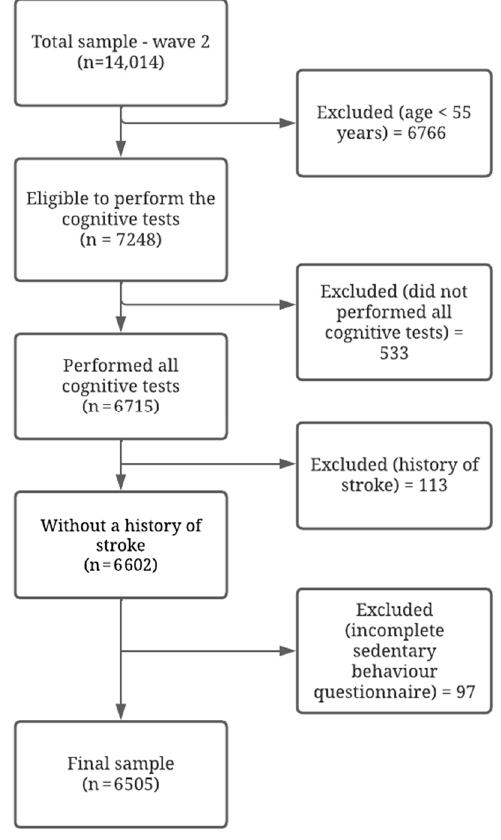
Figure 1. Flowchart of the study sample selection process.